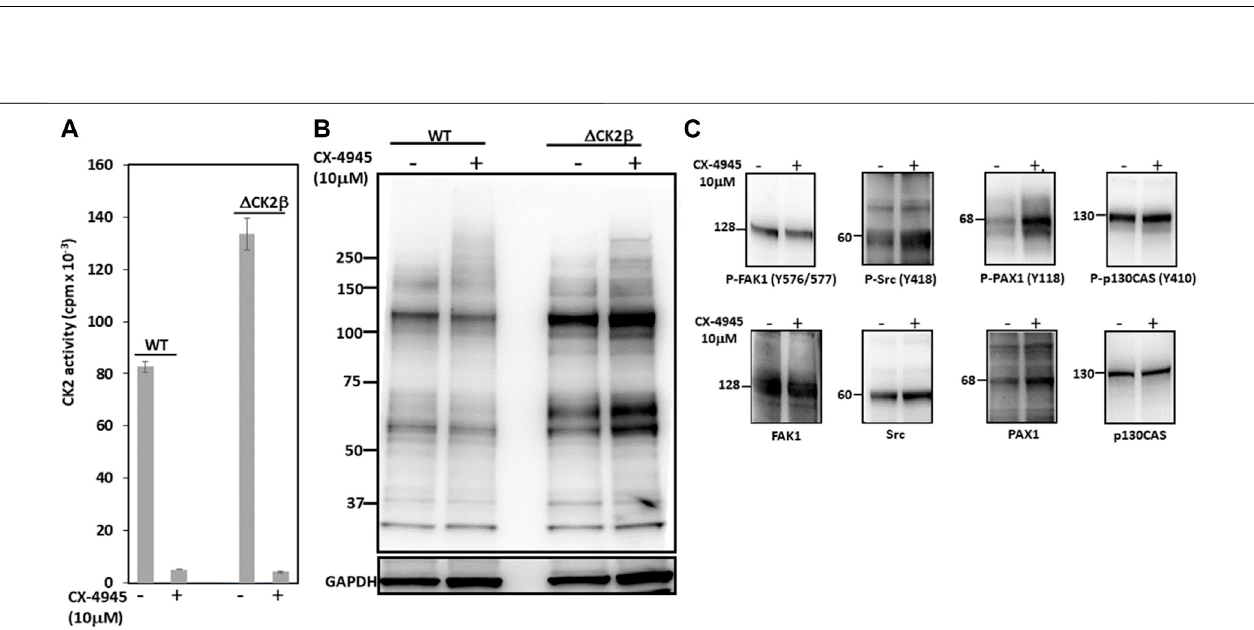
FIGURE4| CellspreadingandsizeoffocaladhesionsaredependentonCK2 β . (A) StainingofpTyrandactinwascarriedoutoncellsspreadonvitronectin-coated coverglassfor24 h.Scalebarrepresents10 µm. (B) Quanti fi cationofthecellarea. (C) Quanti fi cationofthenumberofFAsnormalizedtothecellarea. (D) Quanti fi cation of the FA average area. (E) Quanti fi cation of the FA area, normalized to the cell area. Error bars represent standard deviation. *** p -value ≤ 0.0005.